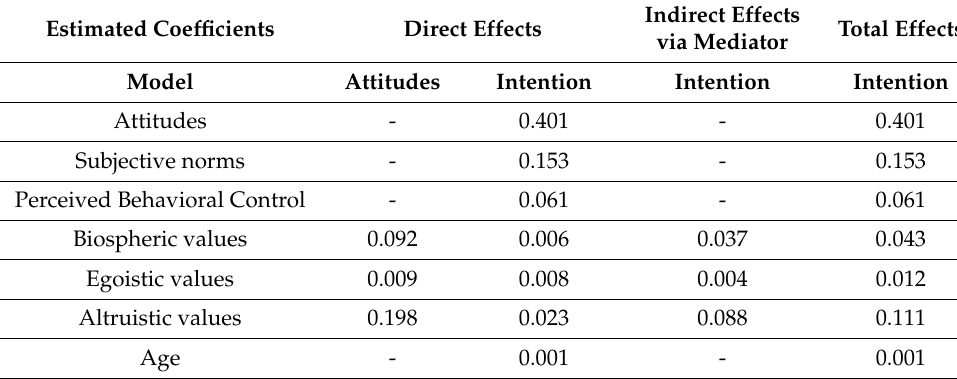
Table 6. Effect sizes for direct, indirect, and total